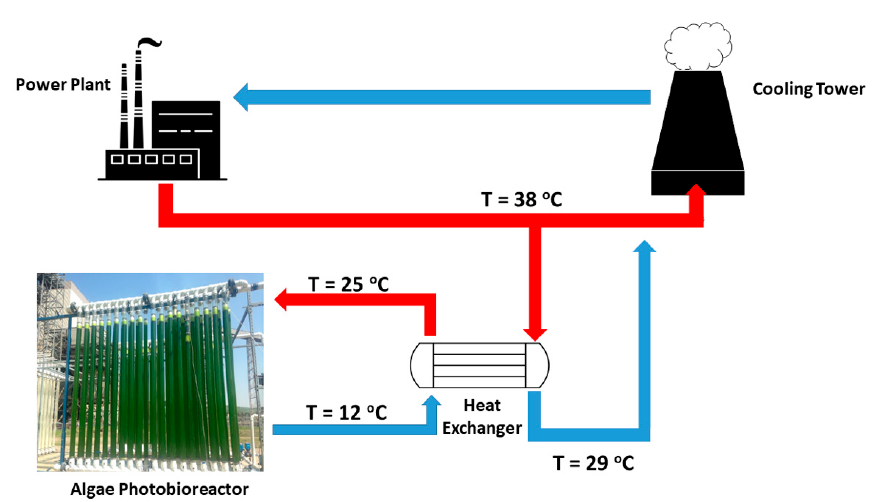
Figure 3. Process flow diagram for heat exchanger used to heat algae cultures from 12 ° C to 25 ° C. A slipstream of water that circulates from the power plant to the cooling towers is simultaneously cooled from 38 ° C to 29 ° C.